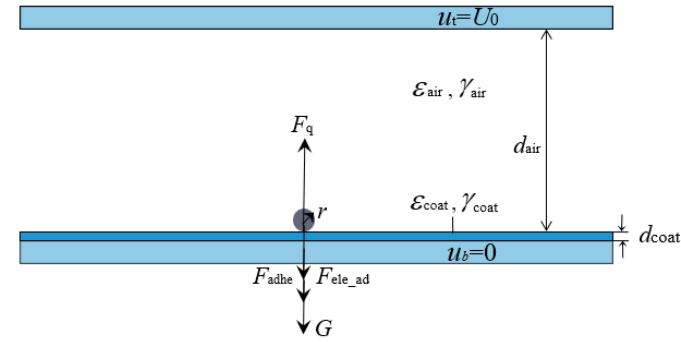
Figure 8. Charging and force model of spherical metal particles. The upper plate is connected to a DC power supply, the voltage is 𝑈 (cid:2868) , the lower plate is grounded and the distance between plates is 𝑑 = 20 mm. The epoxy resin coating air = 50 μ m. The dielectric constant and conductivity of the air gap are 𝜀 (cid:2911)(cid:2919)(cid:2928) thickness 𝑑 coat and 𝛾 , respectively. The dielectric constant and conductivity of epoxy resin coating are air 𝜀 (cid:2913)(cid:2925)(cid:2911)(cid:2930) and 𝛾 coat . The radius of spherical particles is 𝑟 = 0.3 mm. The experiment adopts the method of gradually increasing the voltage. The voltage rise rate is 0.25 kv/s. Wait for 300 s every 5 kV rise, so that the charge can be fully conducted to the particles, and then con- tinue to increase the voltage. In the vertical direction, the particle itself is subjected to gravity, and there is electro- static adsorption force and adhesion work between the particle and the coating. When the electrode is coated, the film is polarized by the electric field, and the charge is transferred to the particle to charge the particle. The two processes are synchronous. The polarization time constant and the charge time constant are equal, and their magnitudes are 𝜏 : 𝜏 = 𝜀 (cid:2868) 𝜀 coat 𝛾 coat (2) where 𝜀 (cid:2868) is the dielectric constant of vacuum. When the upper plate voltage U 0 is in- creased, the electrostatic force of the particle 𝐹 (cid:2927) will increase. When the electrostatic force is greater than the sum of gravity G, electrostatic adsorption force 𝐹 ele_ad and adhesion 𝐹 adhe of the particle, the particle will be lifted. To study the influence of electrode surface coating on the lifting voltage of particles under DC voltage, the authors built the charging and lifting model of metal particles in previous studies. Considering the electrostatic adsorption force provided by the coating can significantly improve the lifting voltage of the particle, the formula of particle lift volt- age at t > 3 𝜏 is calculated experimentally: